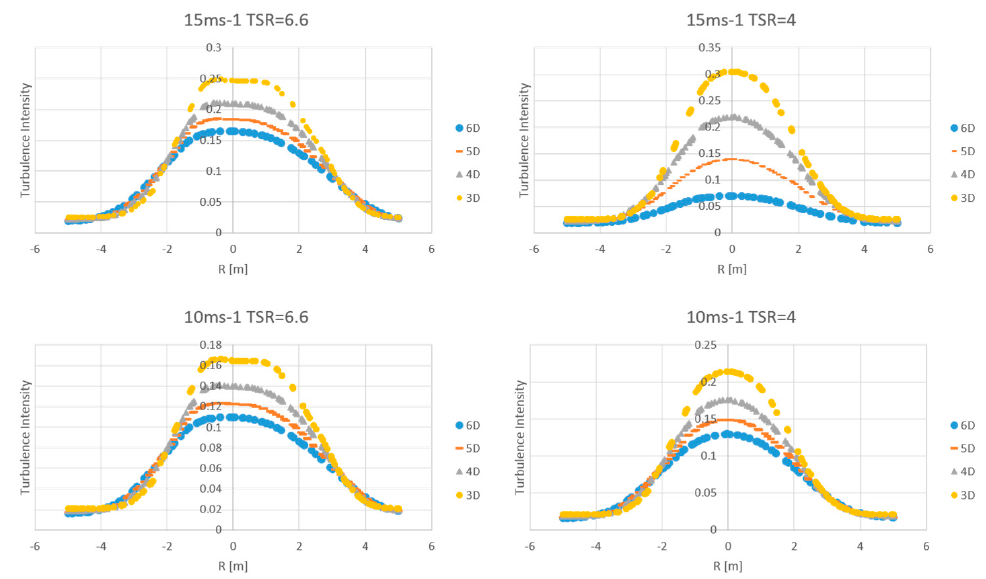
Figure 8. TI for several downstream radial positions and TSR, considering U = 10 m · s − 1 and U = 15 m · s − 1 .